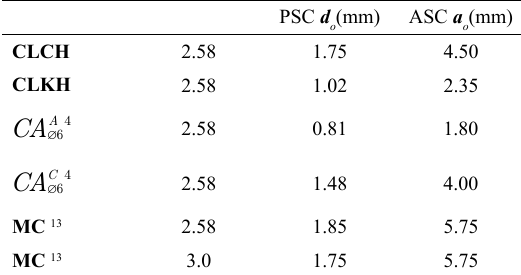
and a for test specimens CLCH o o